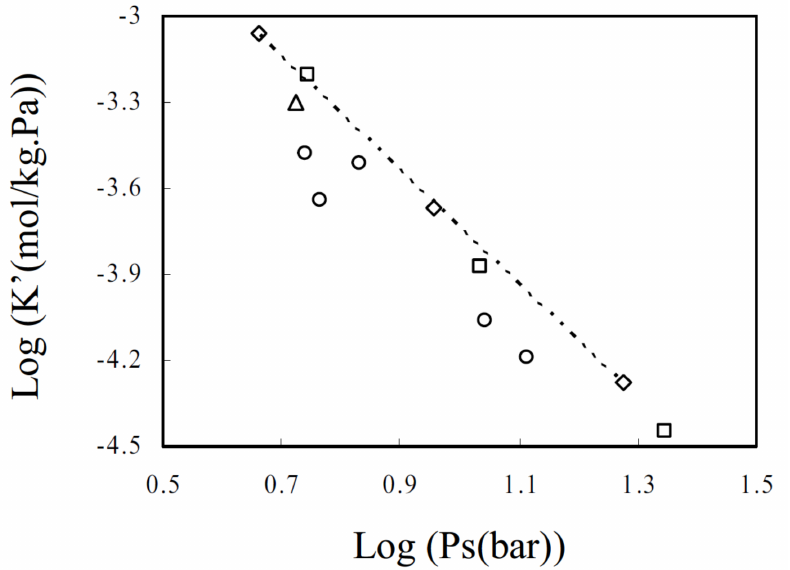
Figure 4. Logarithm of the Henry constants of linear ( ♦ ), 2-methylbranched ( (cid:3) ), 3-methyl-branched ( ∆ ) and dimethyl-branched alkanes (o), calculated from the measured chromatograms at 160 ◦ C, versus the logarithm of their saturated vapor pressure at 160 ◦ C. Reprinted with permission from [49]. Copyright (2007)